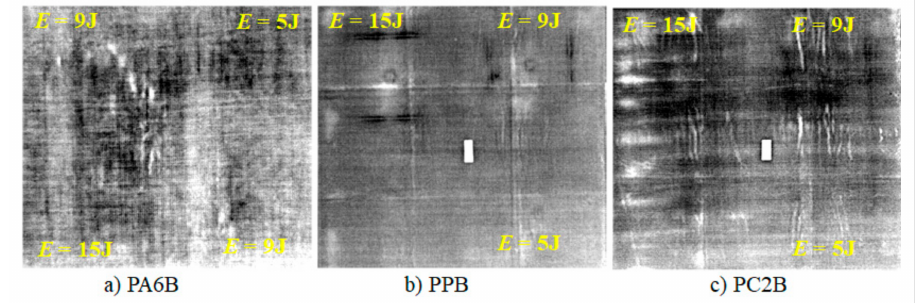
Figure 9. Phase images taken at f = 0.19 Hz on the rear side of the three specimens; ( a ) PA6B; ( b ) PPB; ( c ) PC2B.